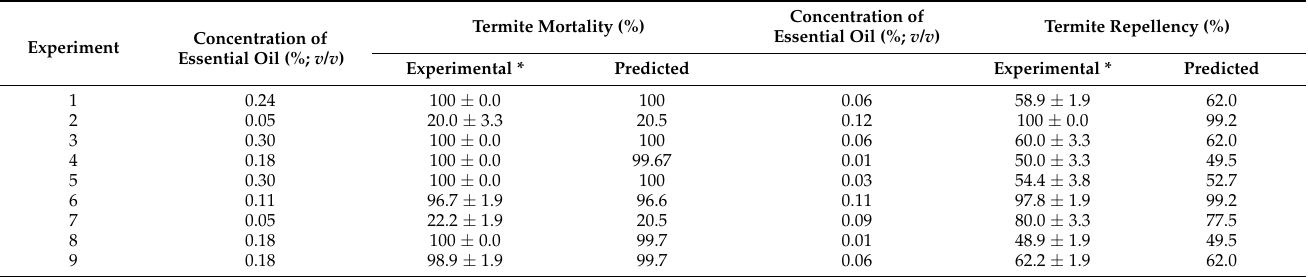
Table 1. One-factor response surface methodology design based upon independent variables (EO concentration) and experimental and predicted results of the antitermitic and repellent activities.